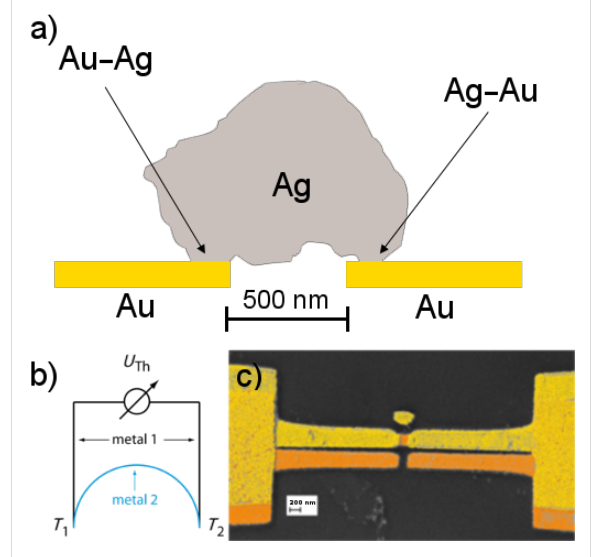
Figure 8: (a) Illustration of the closed contact; a silver crystallite spans the bridge across the gap between the two gold electrodes (about 500 nm). (b) Sketch of the electronic circuit of the model. (c) Coloured SEM picture of a nanothermocouple, fabricated by electron-beam litho-